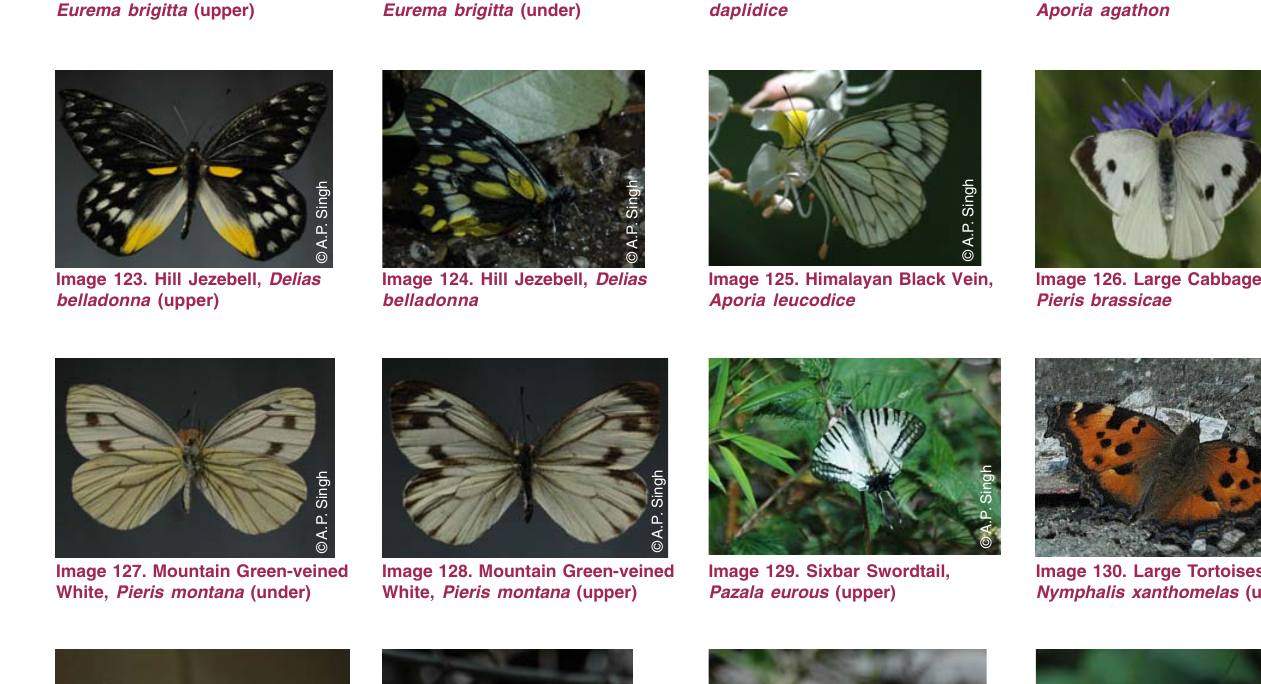
Image 119. Small Grass Yellow, Eurema brigitta (upper)